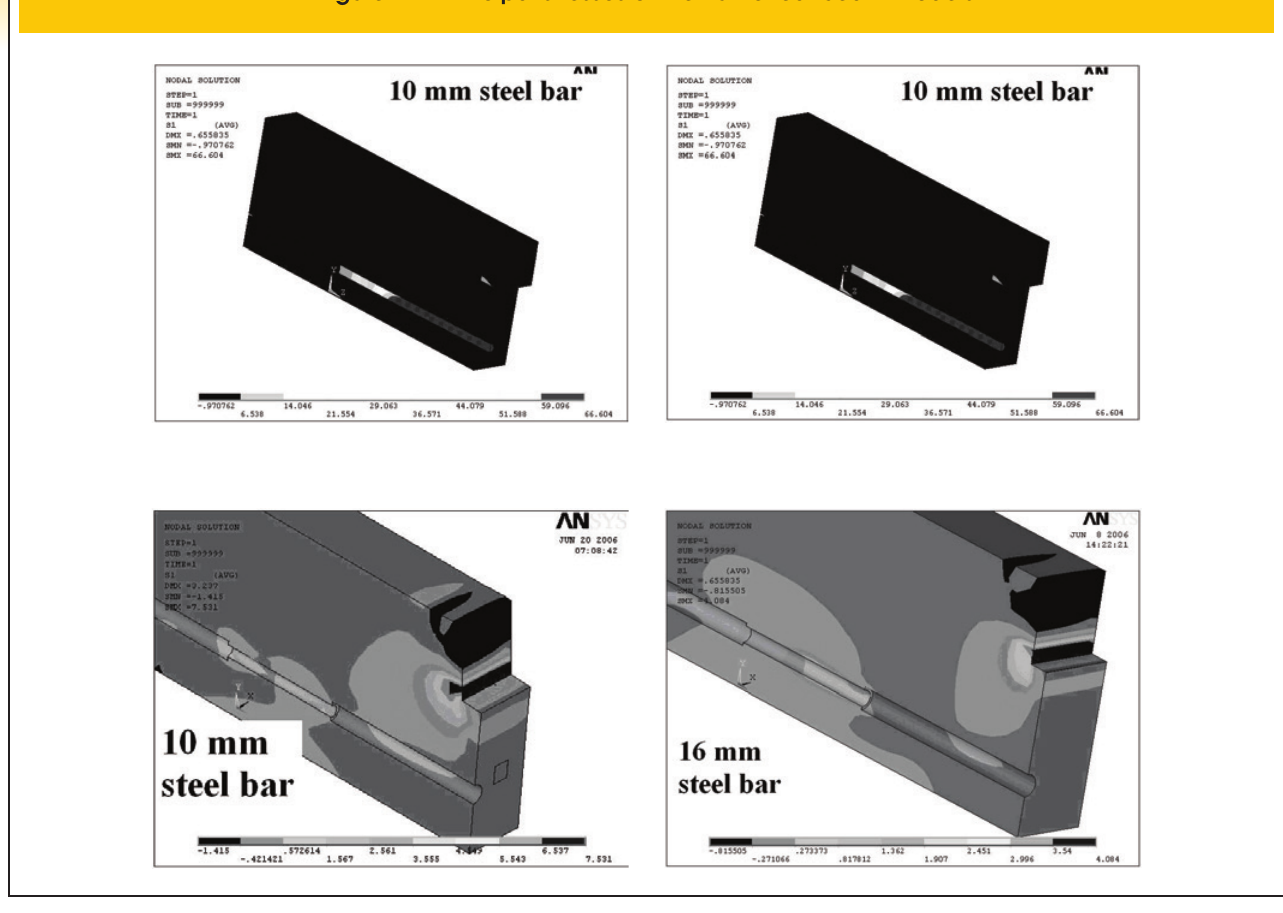
Figure 12 – Principal stresses of the numerical beam models